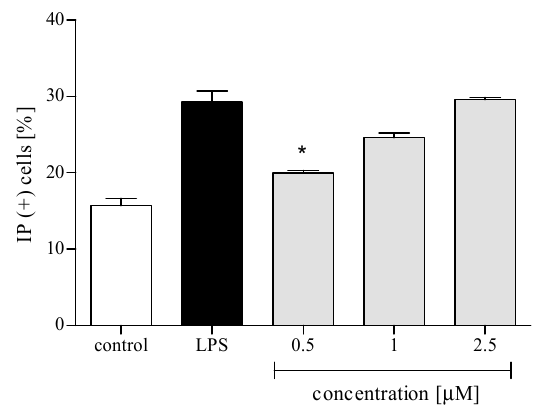
Figure 3. Cytotoxic effects of trans -12-OPDA, at concentrations of 0.5, 1.0, and 2.5 μ M, on lipopolysaccharide (LPS)-stimulated human neutrophils. Results are shown as percent of cells with diminished membrane integrity (propidium-iodide-positive cells, PI (+)). Control, untreated cells; LPS, cells stimulated with LPS (stimulated control). Statistical significance * p < 0.05, with reference to a stimulated control.